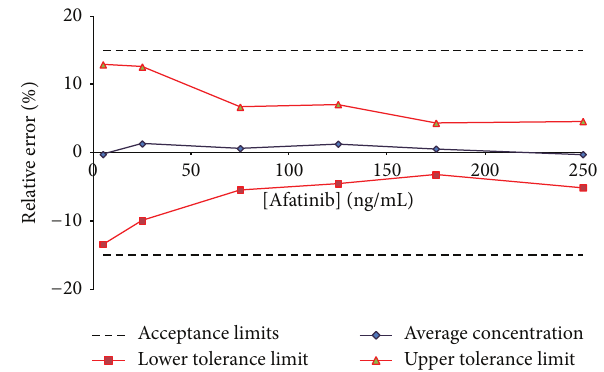
Figure 4: Accuracy profile for afatinib in human plasma; 𝛽 expecta- tion tolerance interval setat 95% and 𝜆 acceptance limits setat ± 15%. All tested concentrations were validated (from 5 to 250 ng/mL).